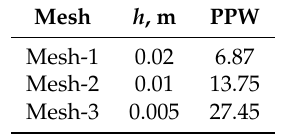
Table 1. Details of three FE meshes (Mesh-1, -2 and -3) for convergence test: h and PPW respectively denote the length of square FE and the number of points per